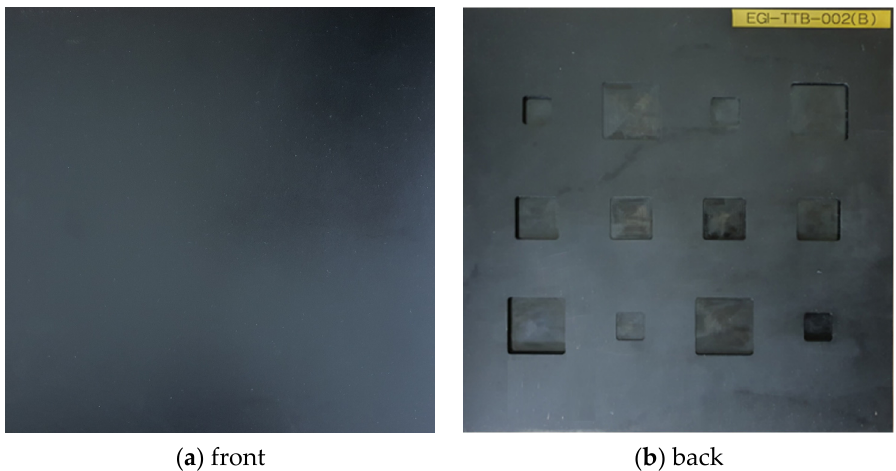
Figure 3. Front and back of S275 specimen with thinning defects.